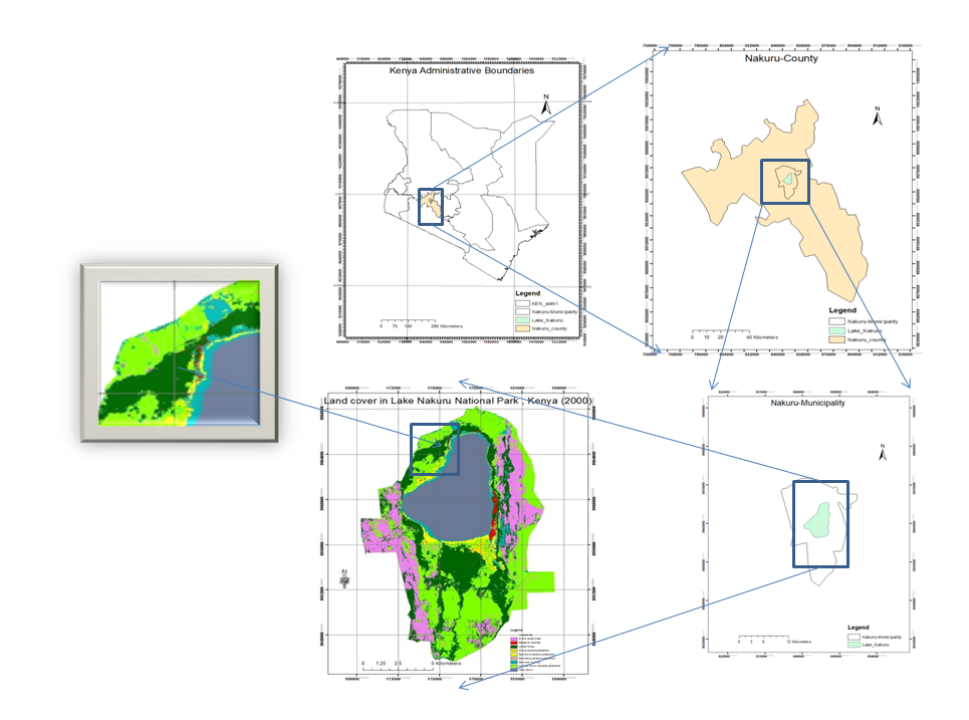
Figure 2: Study Area, located in Nakuru County within Nakuru Municipality (0 ◦ 18’S → 0 ◦ 27’S, 36 ◦ 1.5’E → 39 ◦ 9.25’E),